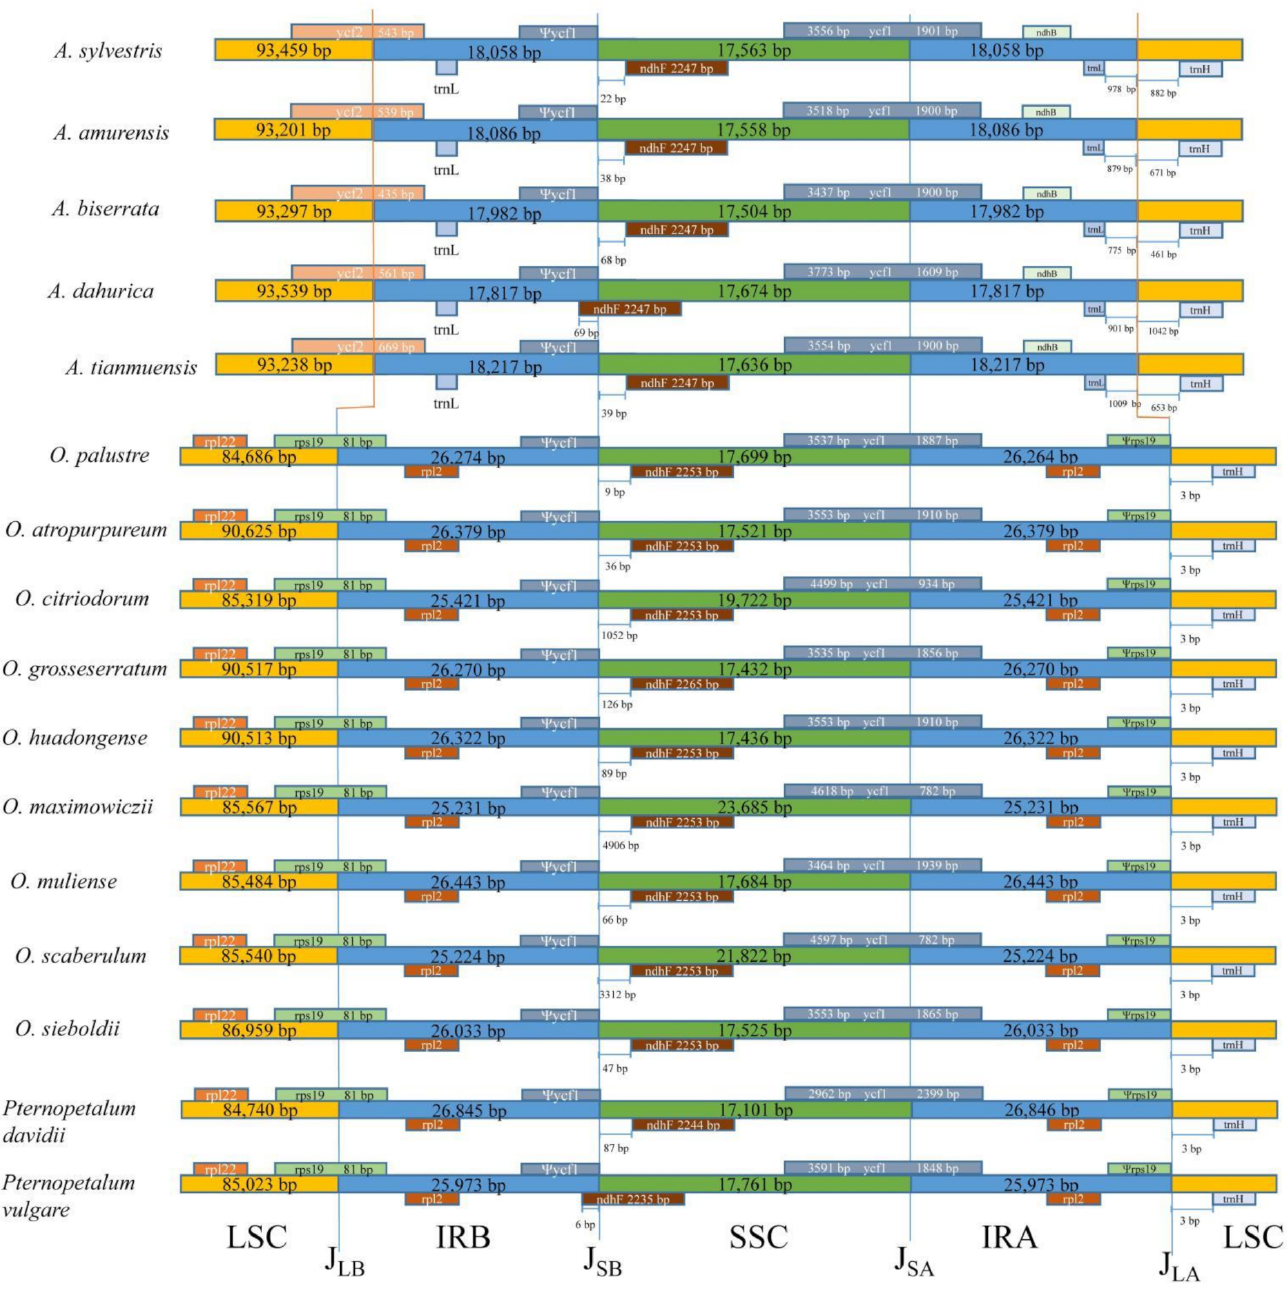
Figure 3. Comparison of the border regions Angelica , Ostericum , and Pternopetalum plastid genomes. LSC (large single-copy), SSC (small single-copy), and IR (inverted repeat)